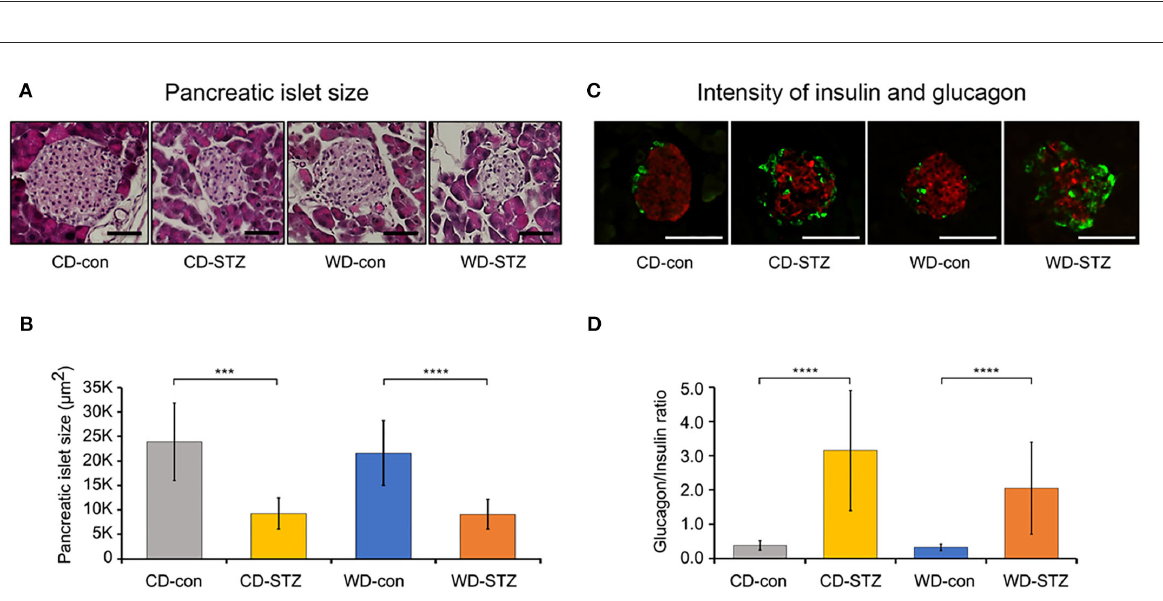
FIGURE5 Pancreatic islet size and glucagon/insulin ratio. (A,B) Decreased pancreatic islet size in STZ-treated mice confirmed on hematoxylin and eosin staining. (C,D) Increased α -cell and decreased β -cell intensities in pancreatic islets of STZ-treated mice. The glucagon (green)/insulin (red) ratio was measured and calculated. *** p < 0.001, and **** p < 0.0001. Scale bars correspond to 50 µ